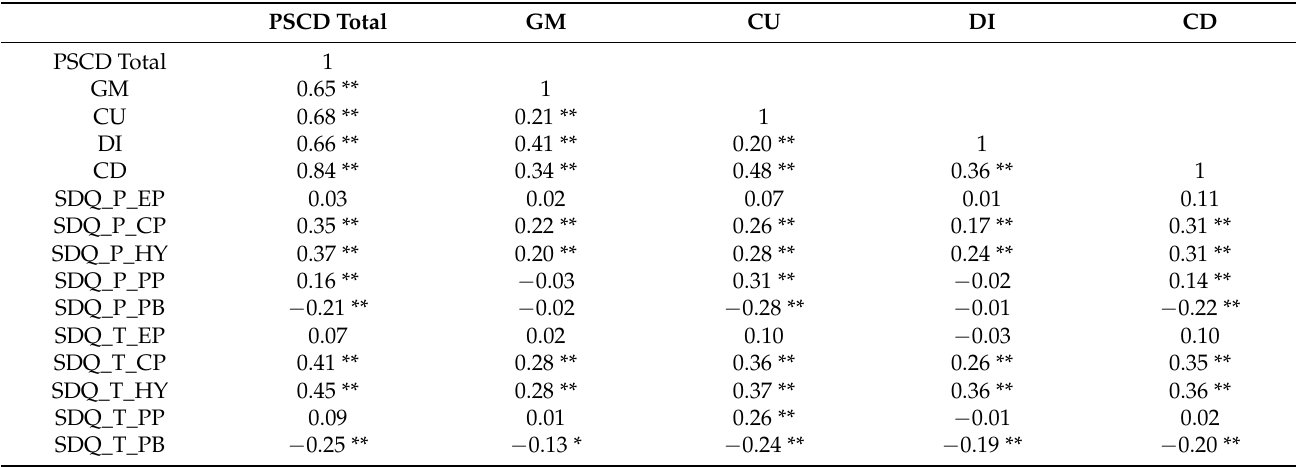
Table 4. Bivariate correlations between the scores of the revised version of PSCD (19 items) and Strengths and Difficulties Questionnaire Parent and Teacher report